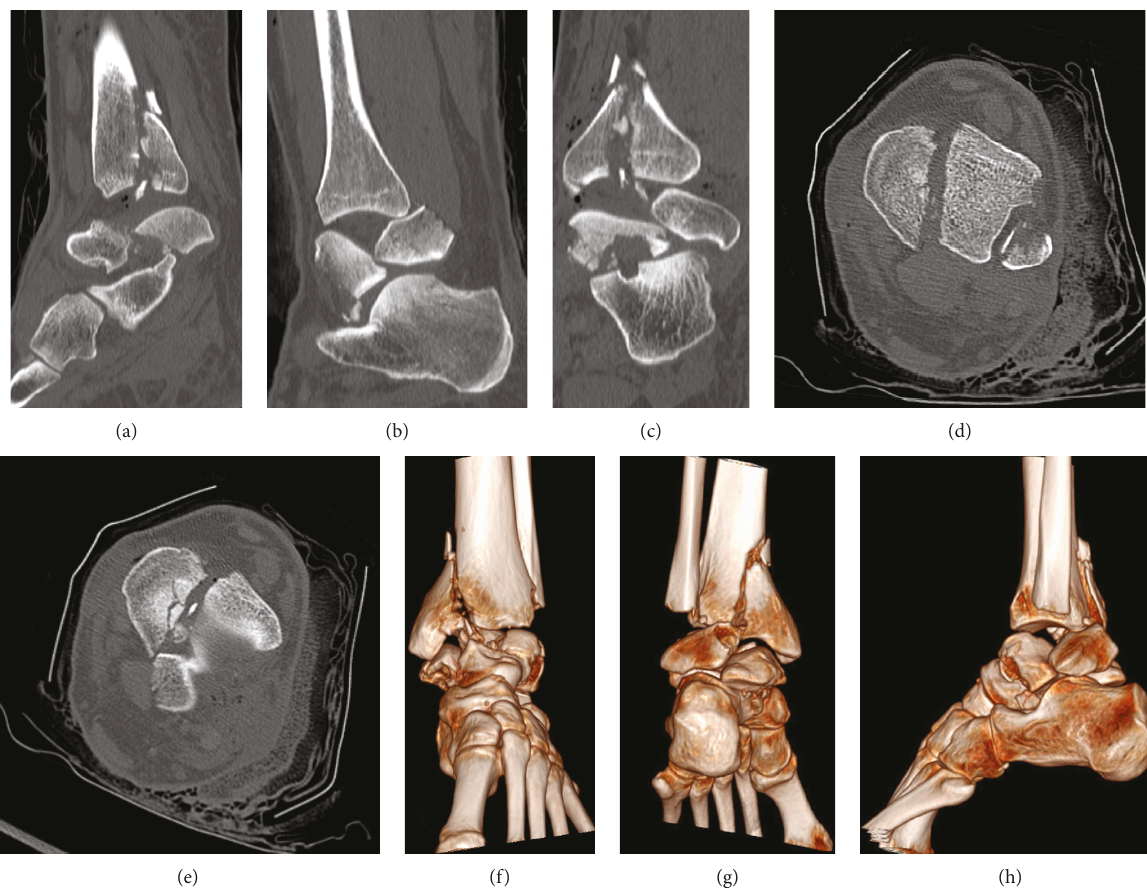
Figure 2: Preoperative CT scan of the left ankle with (a) the sagittal view of the pilon fracture and the split fracture of the talus, (b) distal fi bula pushing the talus fragment anterior, (c) frontal view of the pilon fracture and the talus split fracture, (d) axial view with the fi bula in the incisura, (e) fi bula splitting the tibial plafond, and reconstruction of the left foot in (f) frontal anterior, (g) frontal posterior, and (h) sagittal lateral views.